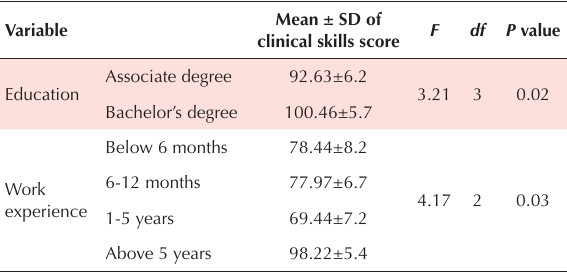
Table 3. Relationship between emergency medical staff clinical skills based on demographic variables and work experience Variable